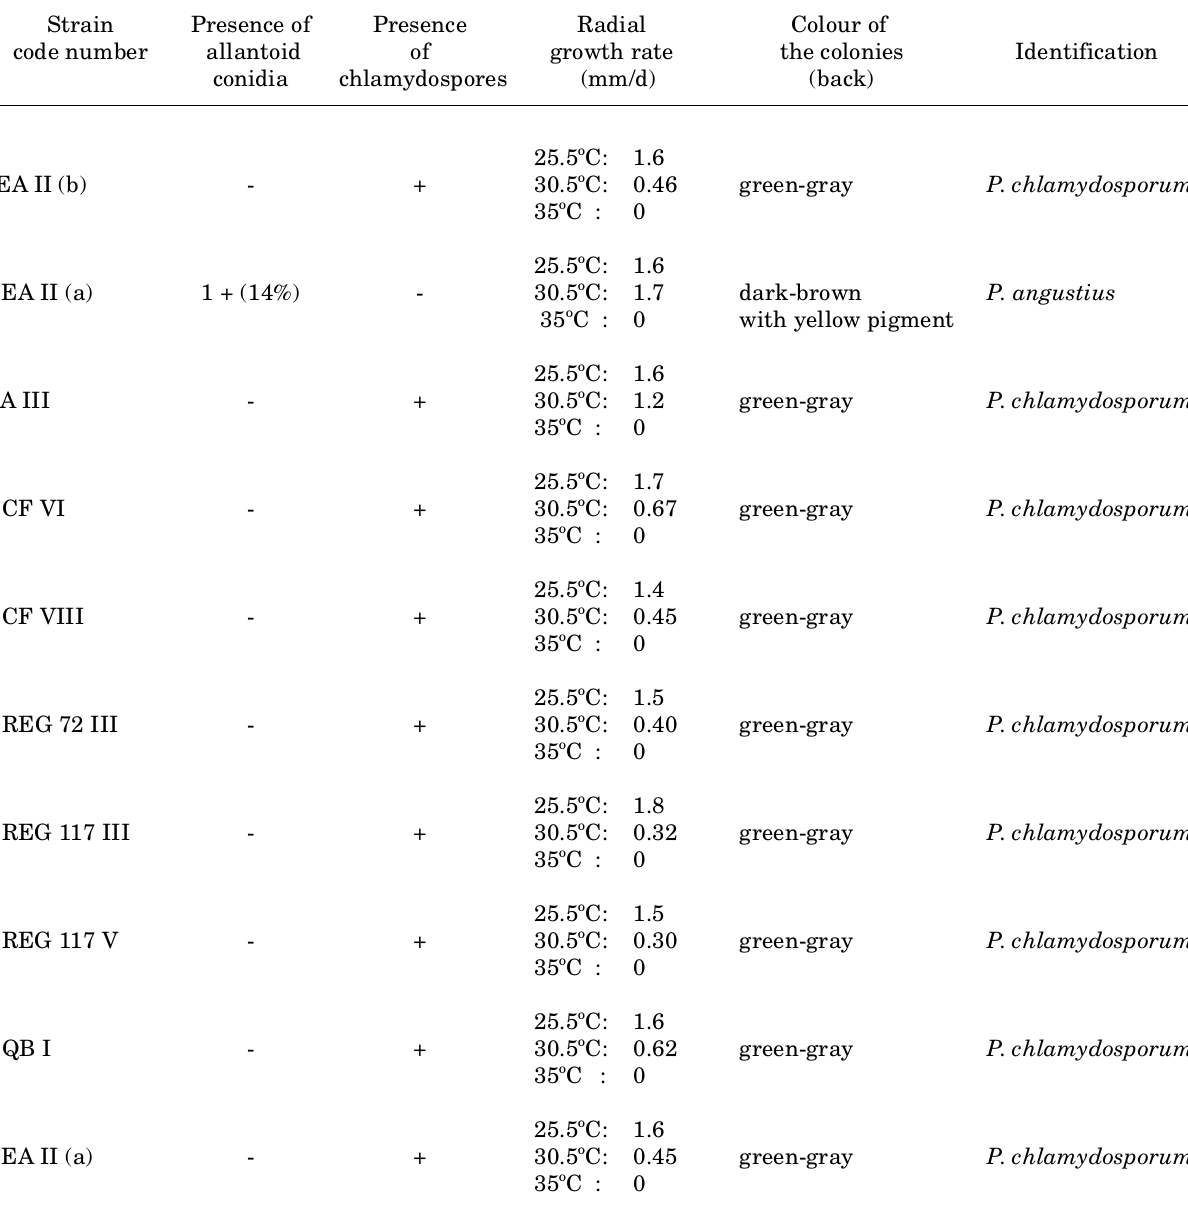
Table 2. Main characteristics and identification of the fungal strains.